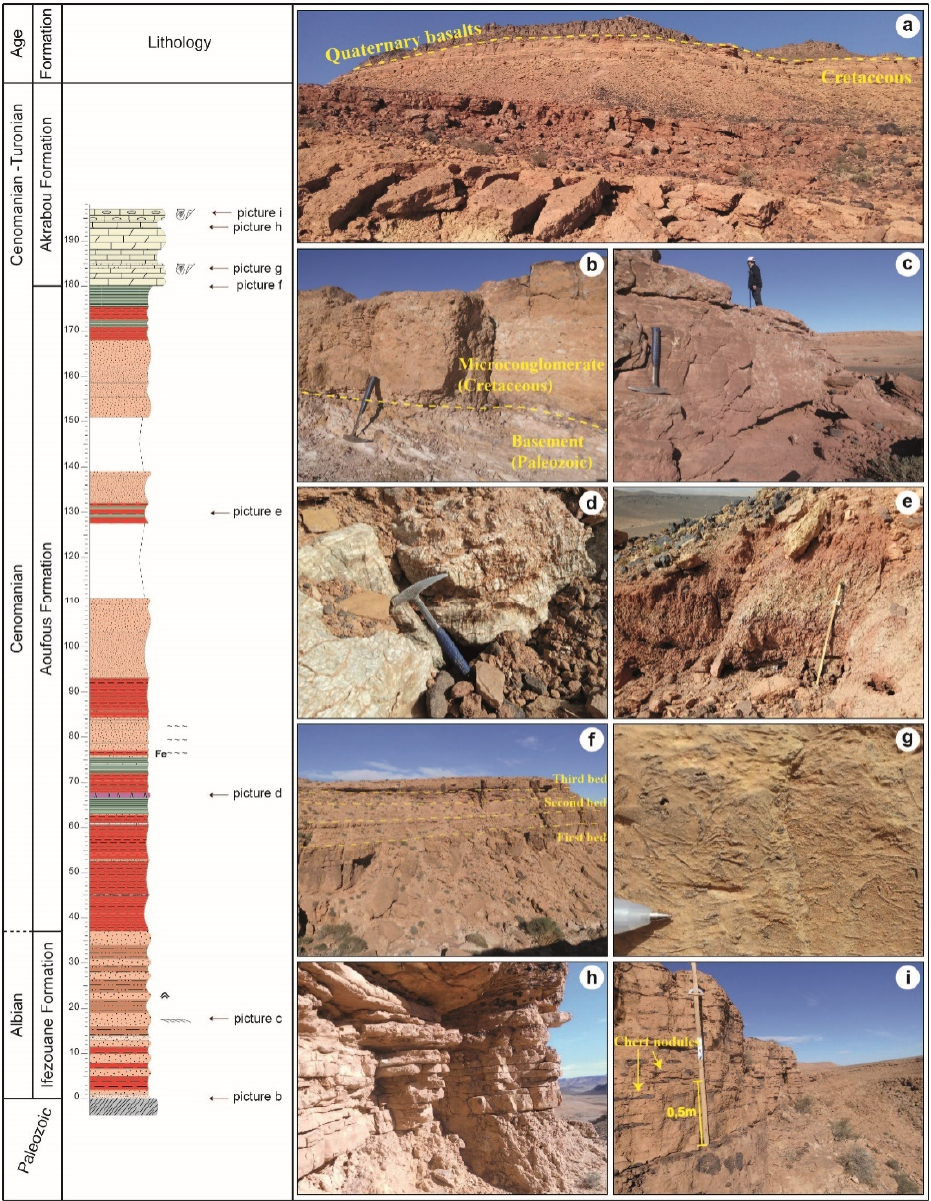
Figure 9. Foum El Kouss section. ( a ) panoramic view showing Cretaceous deposits; ( b ) angular unconformity between the underlying Paleozoic basement and Cretaceous red sandstone; ( c ) red sand-stone bed showing cross-stratification; ( d ) primary gypsum bed; ( e ) red clays with some green marls; ( f ) overall view showing the succession of beds and intervals forming the Cenomanian–Turonian carbonate unit; ( g ) the top surface of a dolomitic bed strewn with bivalve shells; ( h ) interval organized in small limestone layers; ( i ) cross-section view showing nodular and stratiform cherts.